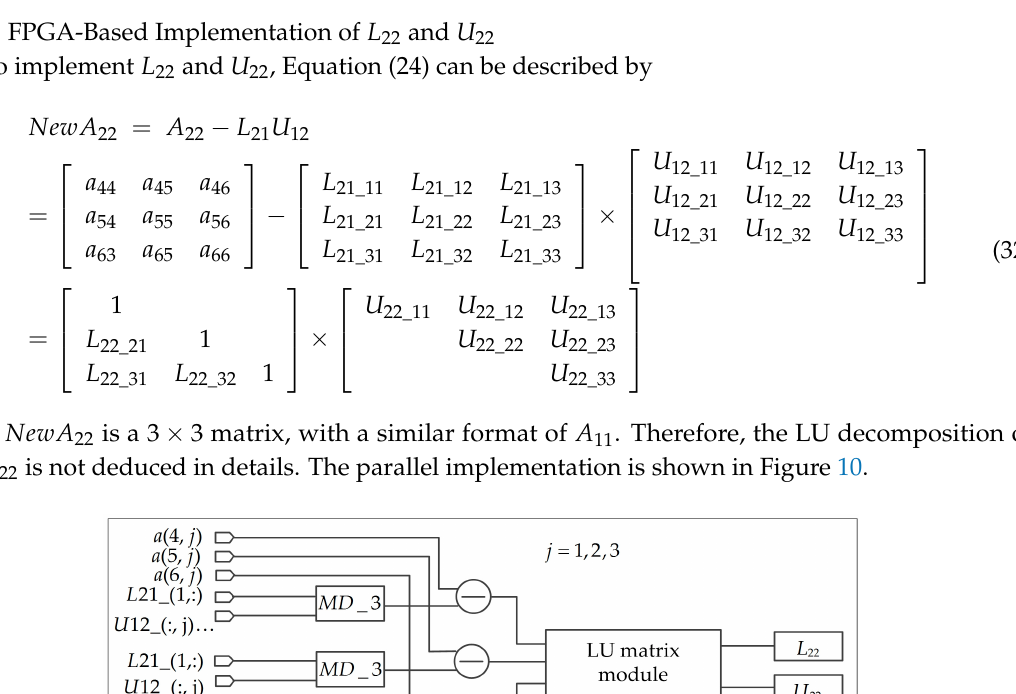
Figure 9. Parallel computation method for L 21 and U 12 . ( a ) The architecture of L 21 . ( b ) The architecture of U 12 .